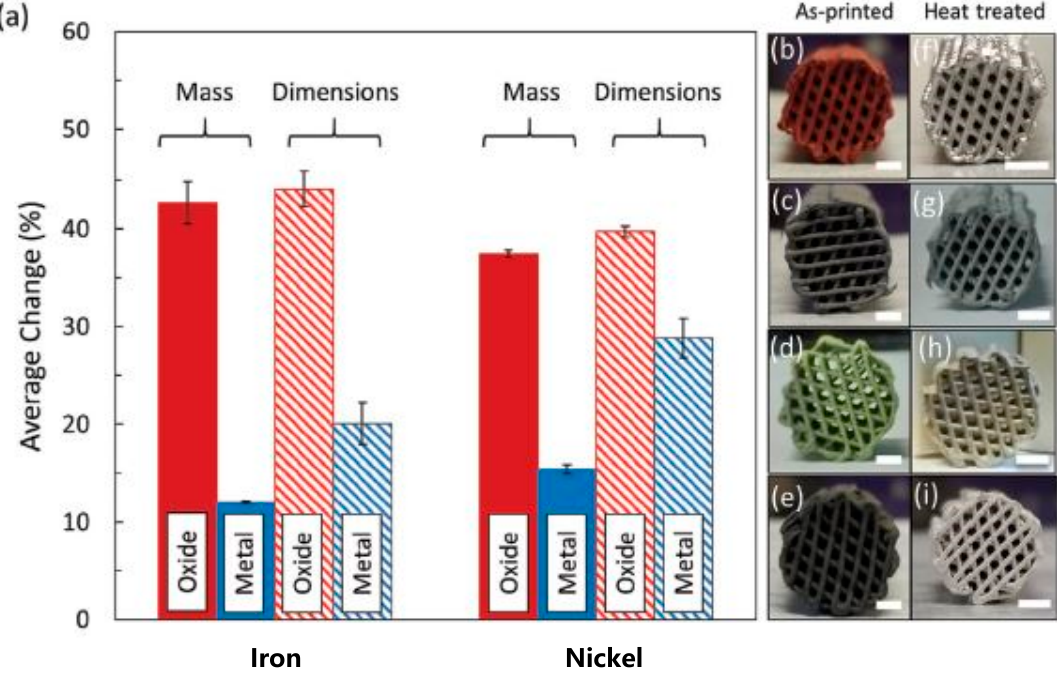
Figure 3. ( a ) Mass and linear dimensional changes for oxide and metal-derived structures made of iron and nickel. Due to the loss of oxygen after oxide reduction, oxide-derived samples have greater changes in mass and dimensions than their metal-derived counterparts [82]. ( b , f ) Samples derived from Fe 2 O 3 particle-based inks. ( c , g ) Samples derived from Fe particle-based inks. ( d , h ) Samples derived from NiO particle-based inks. ( e , i ) Samples derived from Ni-particle-based inks. Scale bars at 2 mm. Reproduced with permission from [117]. Copyright Wiley-VCH, 2016.